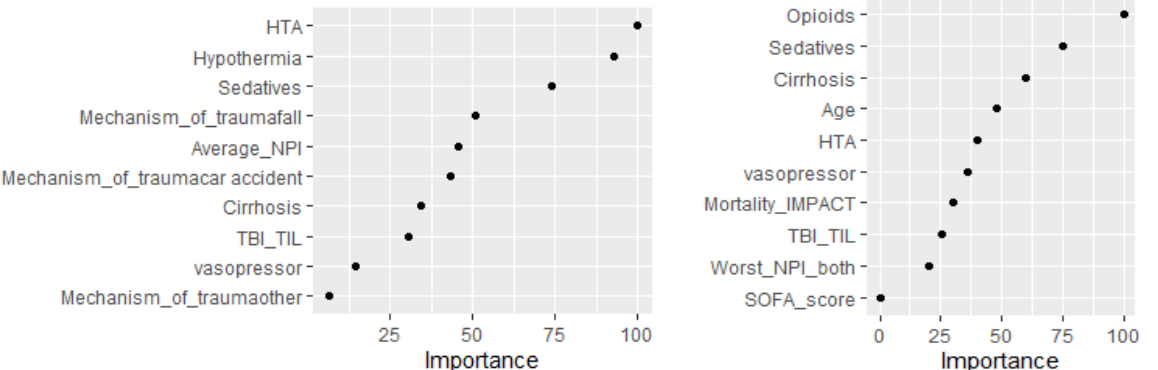
Figure 2. Contribution of selected variables to predict unfavourable neurological outcome (left Panel) or ICU mortality (right Panel). HTA = hypertension; NPi = neurological pupil index; TIL = Therapy Intensity Level; SOFA = Sequential Organ Failure Assessment. Table 3. Regularized regression models with elastic net. The fitted models showed an accuracy of